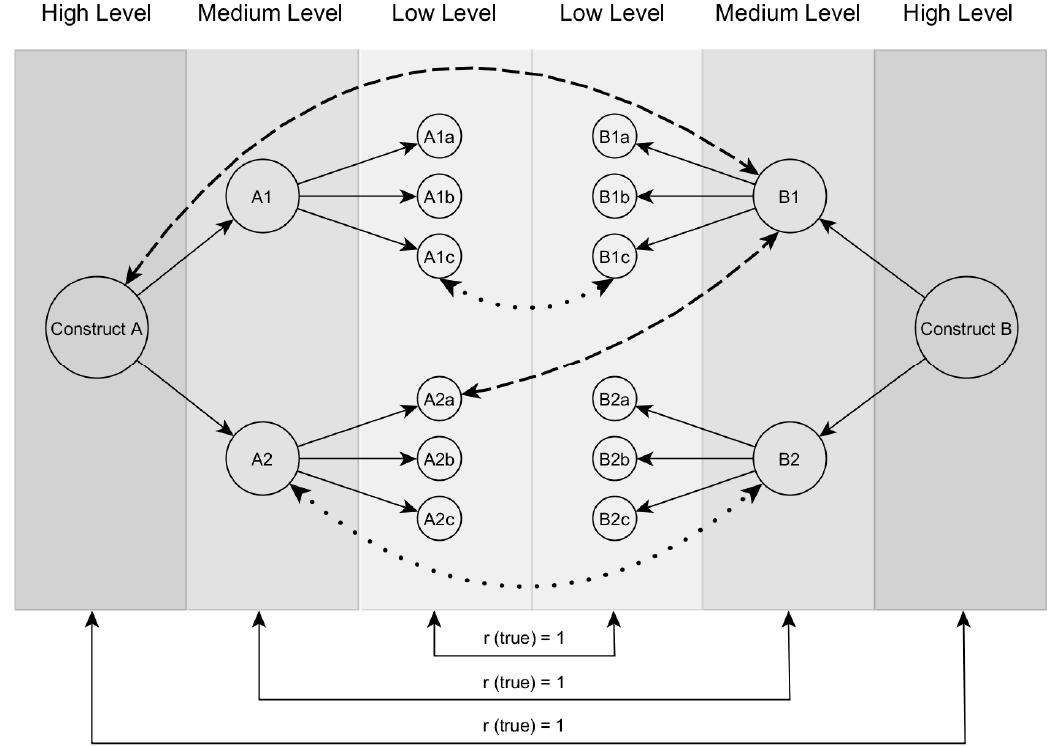
Figure 1. Illustration of the Brunswik symmetry principle according to Wittmann [23,24]. Dotted lines = symmetrical comparison. Dashed lines = asymmetrical comparison.